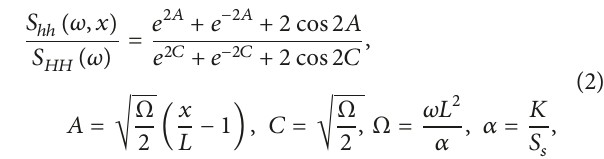
represents porosity. Therefore, 𝛾 of water is 9.8𝐸 + 3 (N/m 3 ); the average 𝛼 𝑚 of sand and 𝛽 of water are 1.0𝐸−8 (m 2 /N) and 4.4𝐸 − 10 (m 2 /N), respectively [28, p. 55]. For the artificial island, Chien and Lin [27] found that 𝑛 is 0.41. Based on those analyses, 𝑆 𝑠 is 9.98𝐸 − 5 m −1 and the spatially averaged hydraulic diffusivity ( 𝛼 ) is 3.61𝐸 + 2 m 2